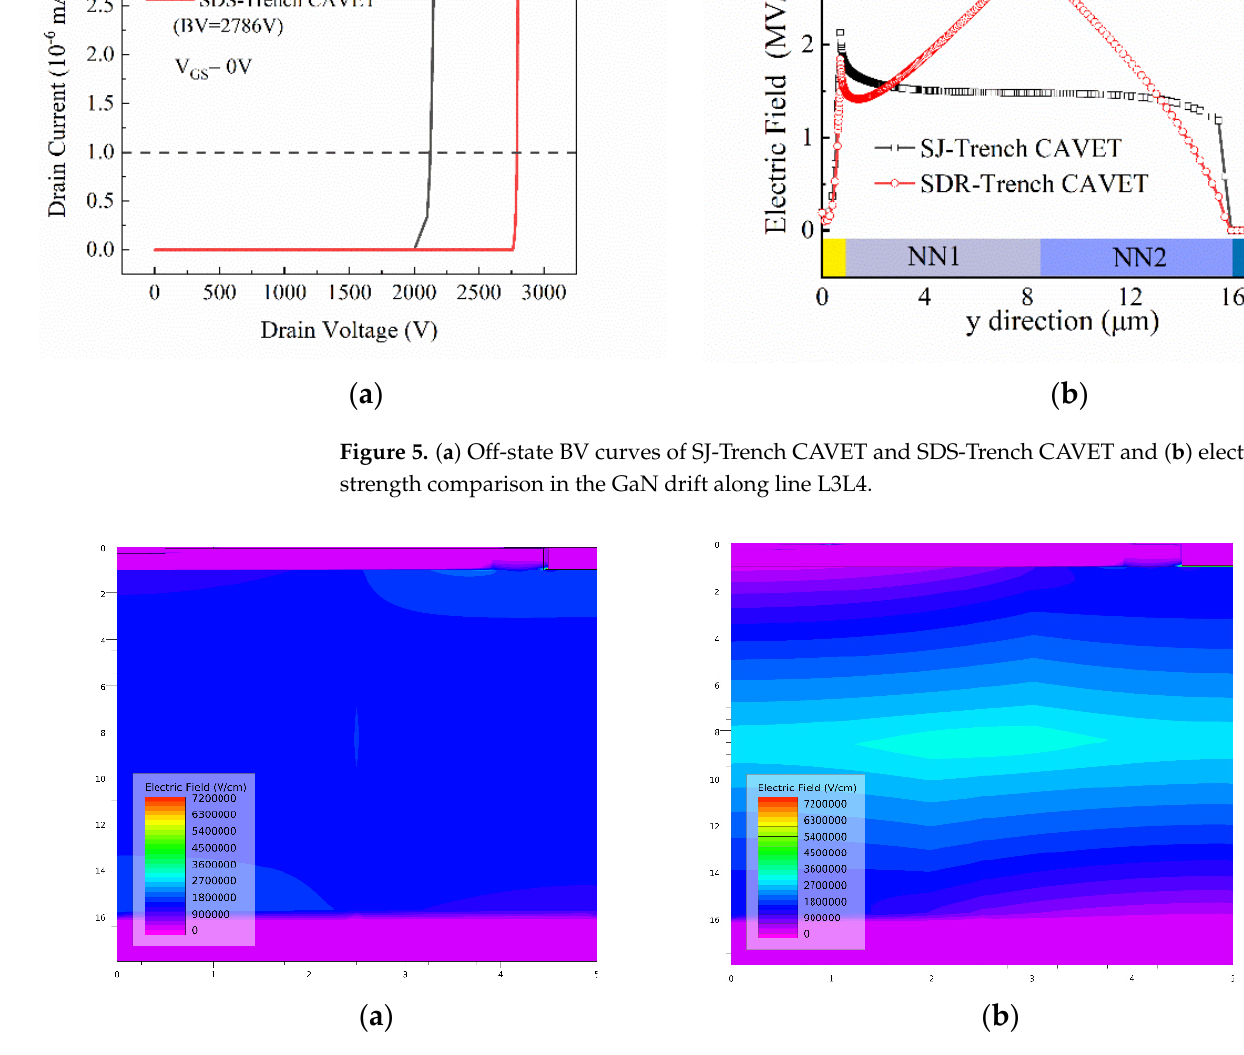
Figure 6. Corresponding entire-electric-field contour plots of ( a ) SJ-CAVET and ( b ) SDS-CAVET In Figure 7, the off-state potential equipotential lines show similar slopes in the SJ- Trench CAVET and SDS-Trench CAVET, which guarantee device stability in breakdown performance. Compared with the SJ-Trench CAVET, in the SDS-Trench CAVET, the low- potential areas below the CBL move down slightly, and the high-potential areas above the substrate move upward a lot, causing narrower medium-potential areas. The variation in equipotential-line densities verifies the electric-field-distribution result in Figure 5, whereby the electric-field strength near the middle is enhanced, while that near the bottom is degraded in n- and p-pillars. The total enlarged high-potential distribution in the bottom area is beneficial for breakdown performance, especially during reverse